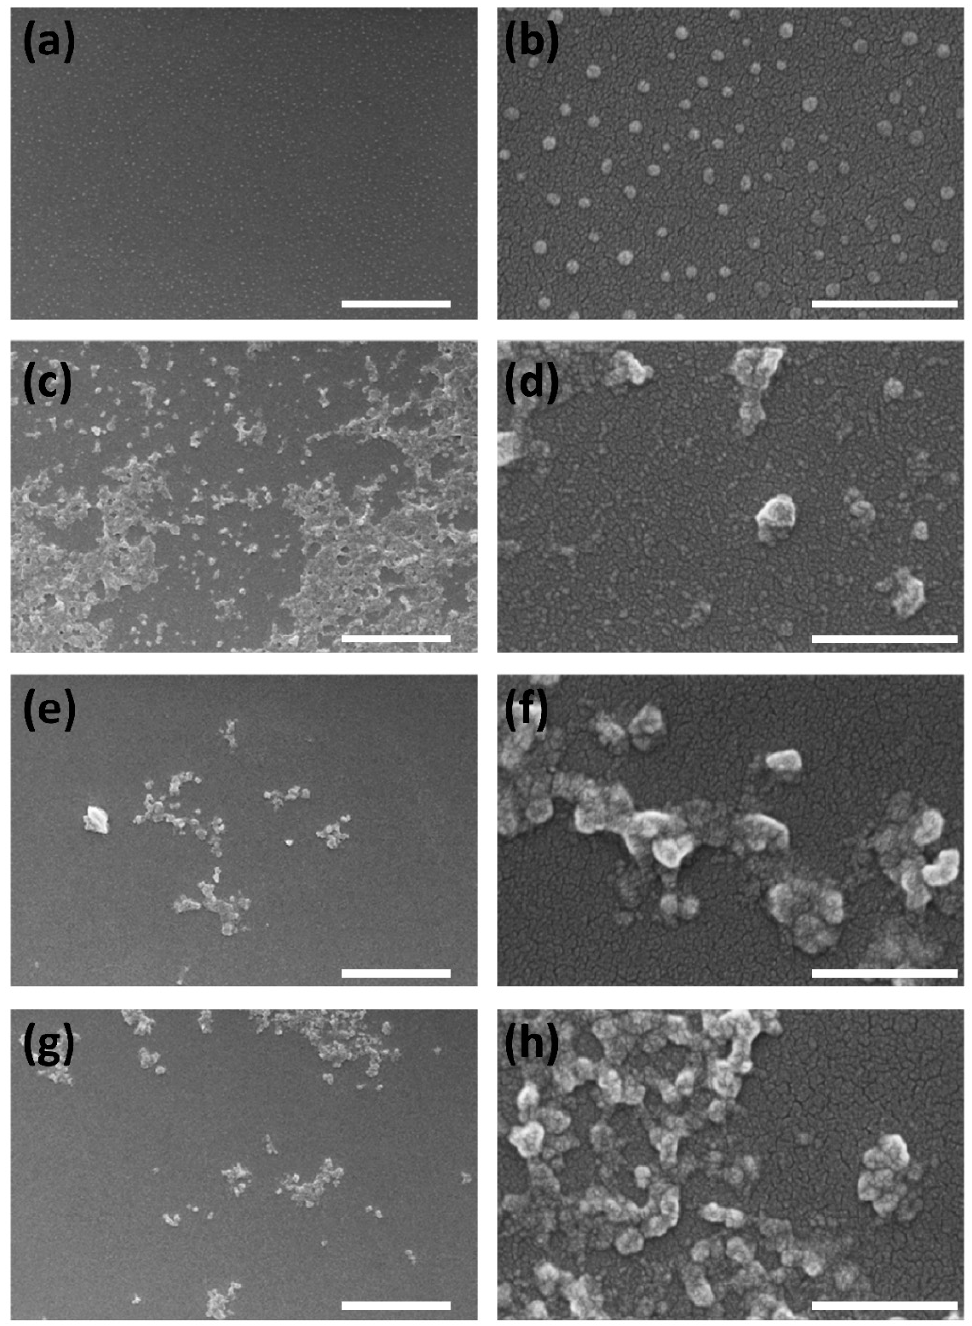
Figure 5. FESEM images of the nanoparticles used for the biological tests at different magnifications: SFN ( a , b , as controls), SFN-CUR ( c , d ), SFN-Q ( e , f ) and SFN-RES ( g , h ). Scale bars 2 µ m ( a , c , e , g ) or 400 nm ( b , d , f , h ).